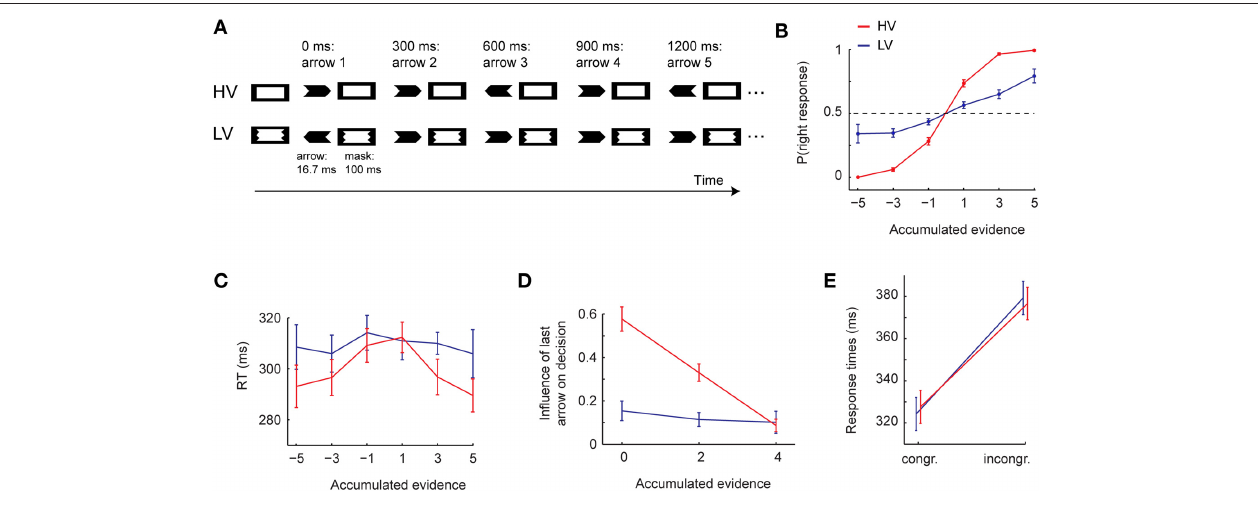
FIGURE 4 | (A) Task-set-up. (B) Decision-making performance as a function of accumulated evidence. Negative and positive numbers denote evidence for a left- and right-hand response, respectively, (number of right-pointing arrows minus number of left-pointing arrows). (C) Reaction times as a function of accumulated evidence. (D) Influence of the last arrow on the final